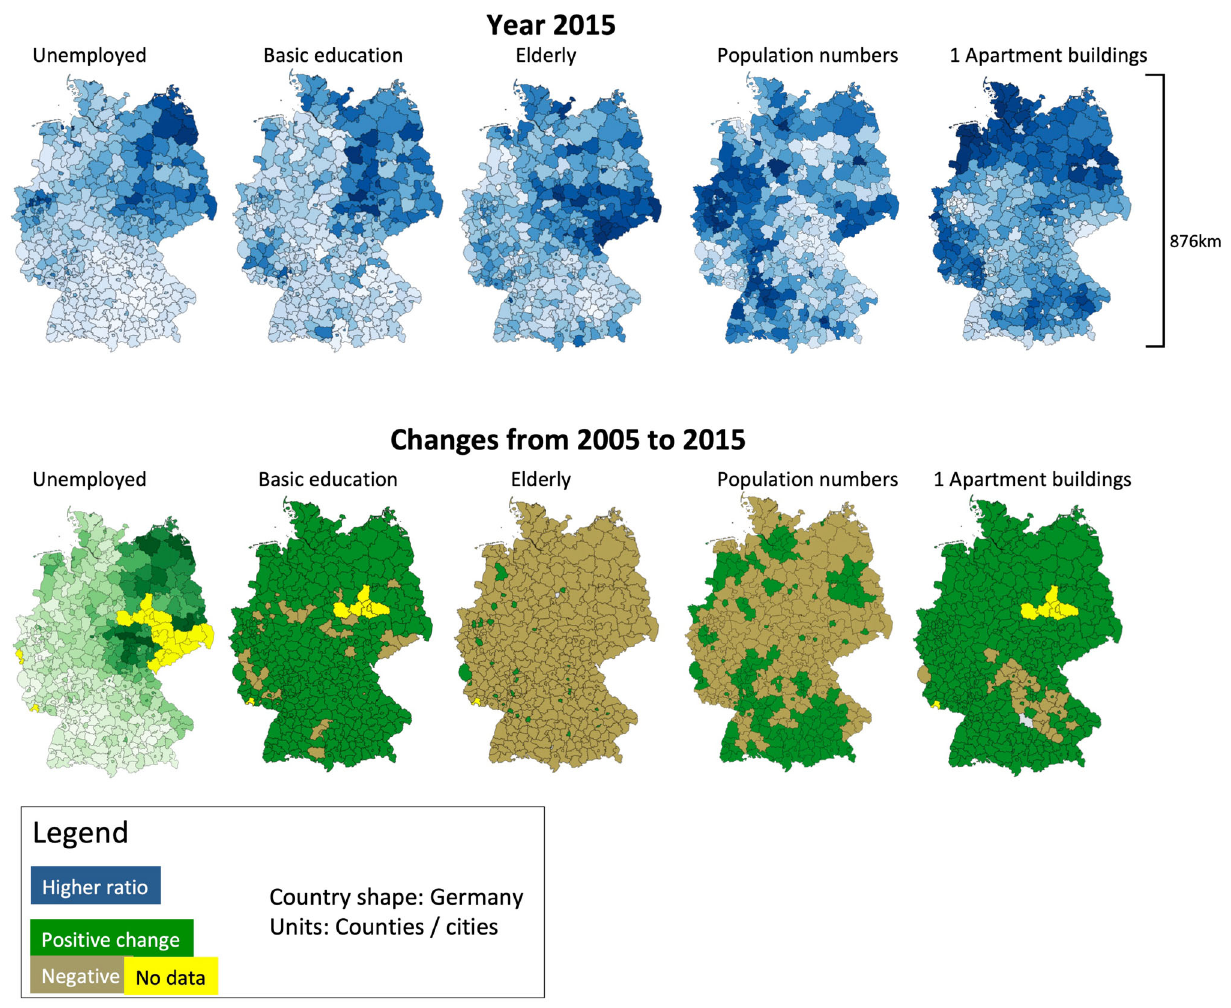
Fig. 2 Indicator maps related to social vulnerability in Germany at county and city administrative levels. Data source Administrative digital boundaries were retrieved from Federal Office of Cartography